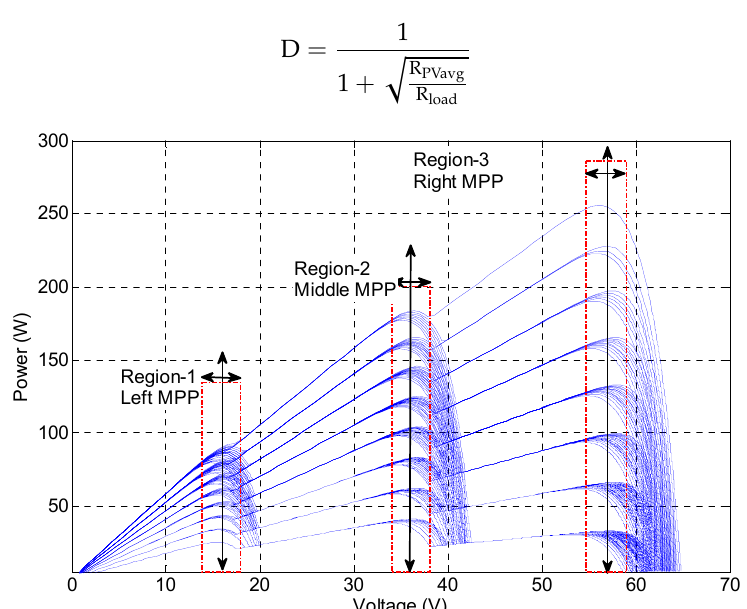
Figure 4. Typical P-V curves of the module under 120 shading cases.